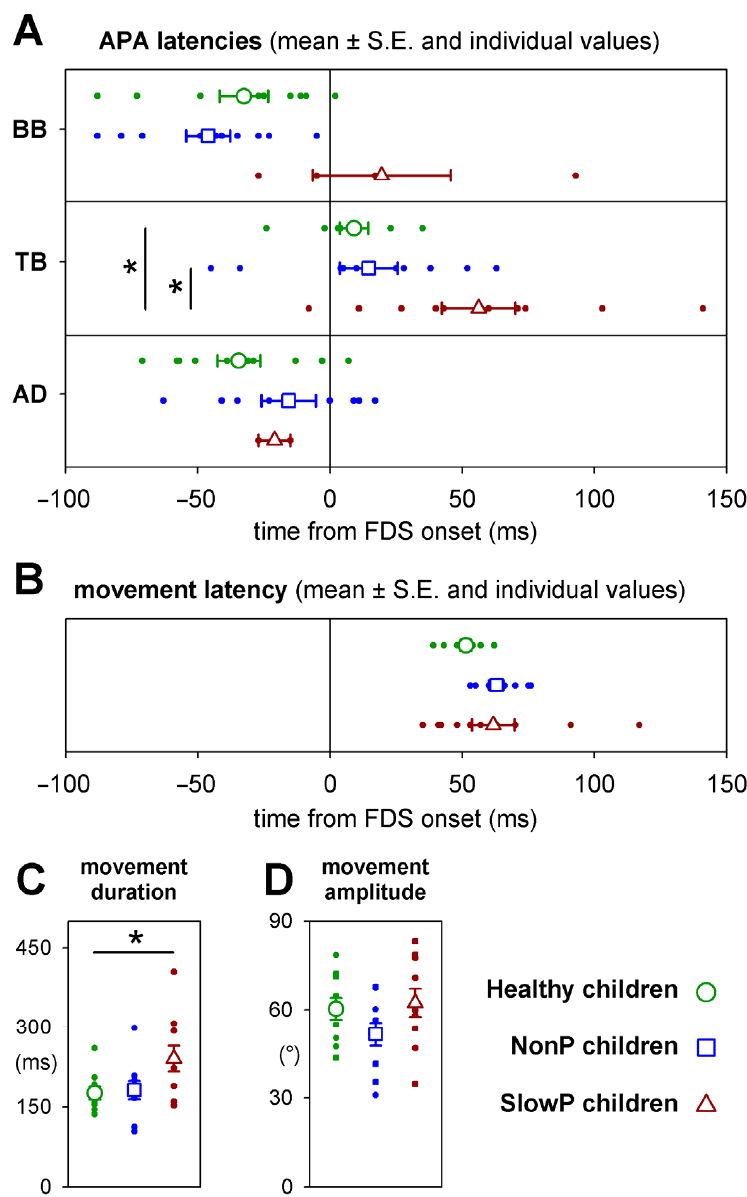
Figure 3. ( A ) Mean APA latencies in the three groups of patients ± SE (open symbols), together with individual values (filled circles), measured with respect to the FDS EMG onset. No significant timing differences occurred between NonP and Healthy children. In SlowP, the excitatory APA in TB was present in all 10 children but was significantly delayed with respect to both Healthy and NonP subjects, while inhibitory APAs could be detected in the BB in only 4 children and in the AD in only 2 children. ( B ) Latency, ( C ) duration and ( D ) amplitude of index finger movement in the three groups; same symbols as in panel ( A ). Latency and amplitude were comparable in the three groups, while movement duration was significantly longer in SlowP children. Significant differences are denoted by an asterisk (*).